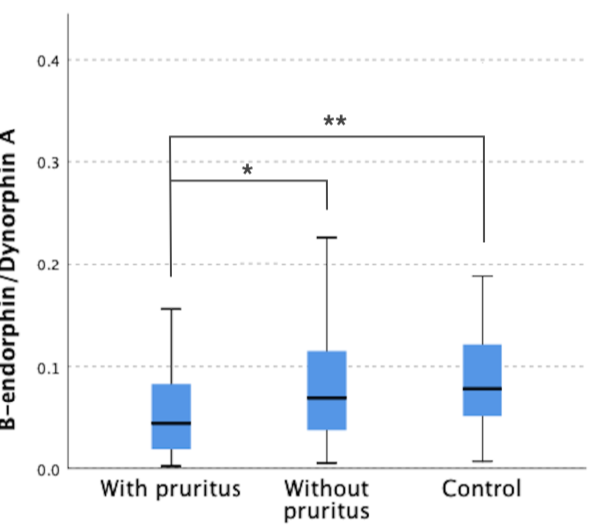
Figure 3. β-endorphin /Dynorphin A concentrations ratio in all study groups. * p < 0.05; ** p = 0.005.